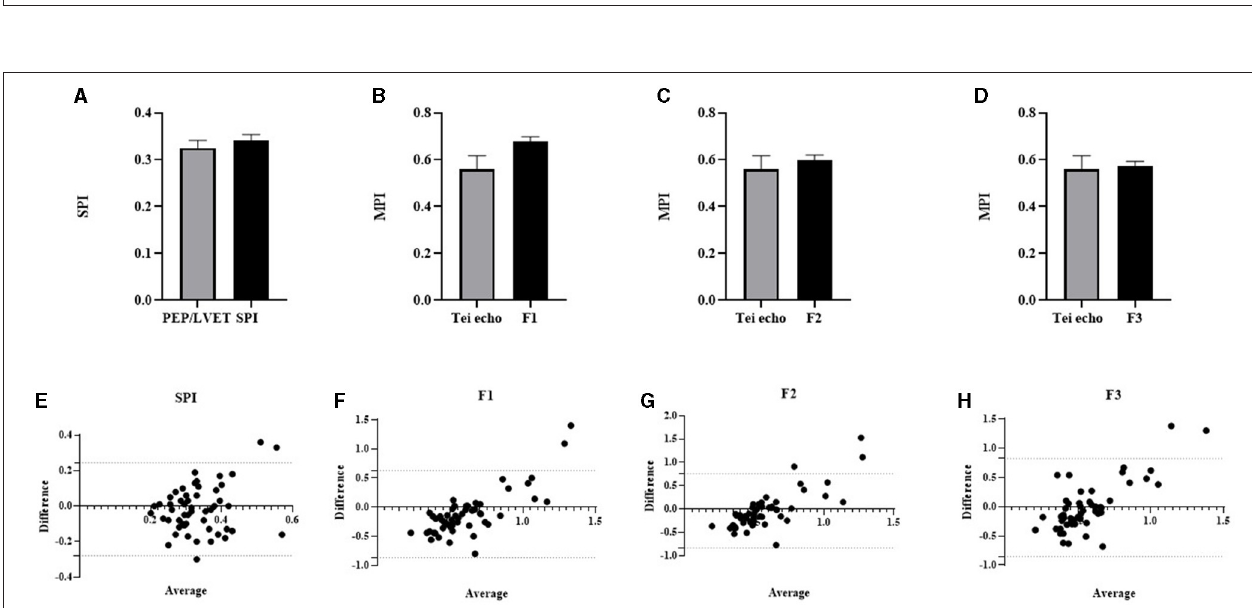
FIGURE 6 | Column bar graph of mean CTI parameters from Eko® DUO ECG + Stethoscope device and standard trans-thoracic echocardiography were compared: PEP/LVET vs. SPI (A) ; Tei index from echo vs. MPI-F1 (B) ; Tei index from echo vs. MPI-F2 (C) ; Tei index from echo vs. MPI-F3 (D) . Data were expressed as mean ± SEM and compared using unpaired t -test at p ≤ 0.05. The Bland–Altman test for the two different methods was used to compare PEP/LVET and SPI (E) , Tei echo and MPI-F1 (F) , Tei echo and MPI-F2 (G) , and MPI-F3 (H) . The horizontal dash lines indicate 95% CI. CTI, cardiac time interval; PEP, pre-ejection period; SPI, systolic performance index; MPI, myocardial performance index; LVET, left ventricular ejection time.